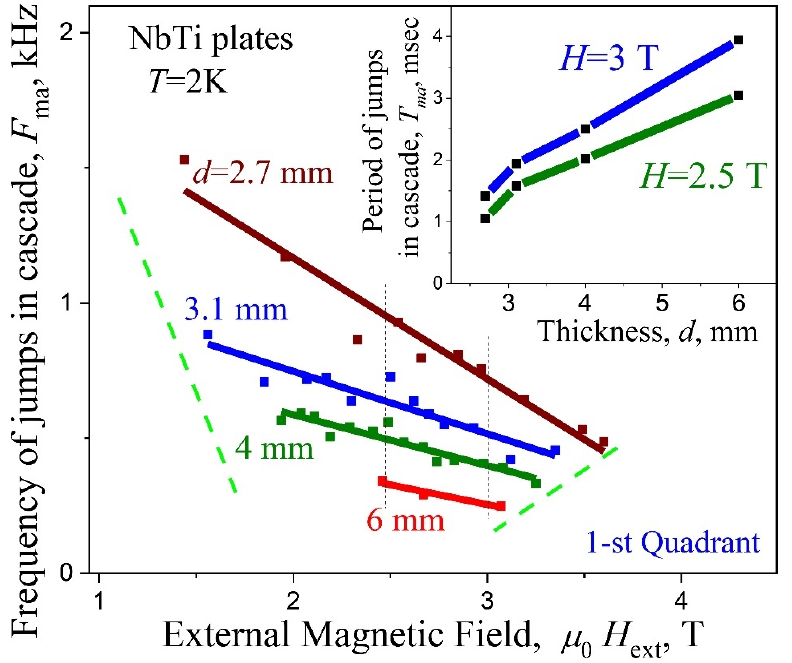
Figure 10. Frequency F ma vs. H ext for plates with different thickness d ; screening regime (1st quadrant). Insert—the value of period T ma = 1/ F ma along vertical lines at the magnetic field µ 0 H ext = 2.5 and 3 T on main frame vs thickness d of plate.